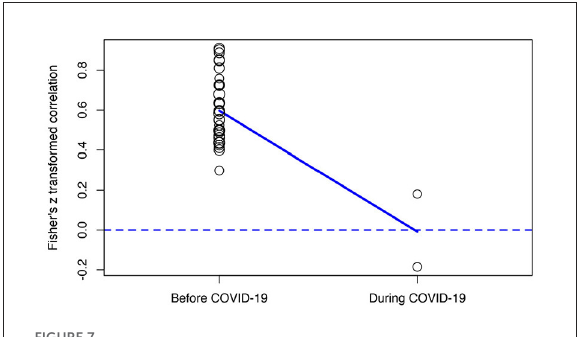
FIGURE7 Meta-regression performed with COVID-19 process as moderator.